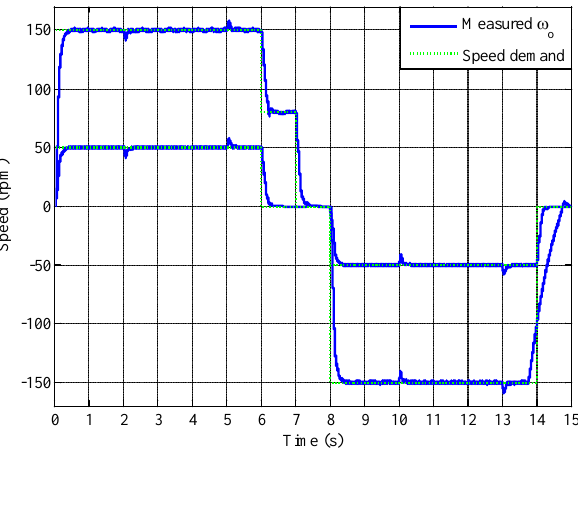
Figure 22. LSR under SFBK control and 50 Nm load